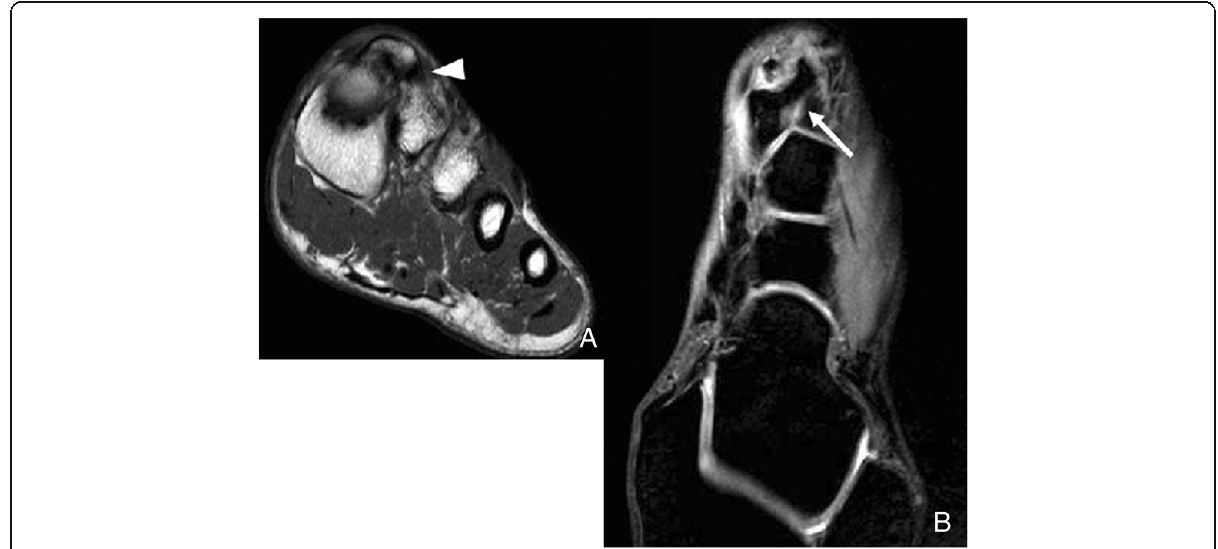
Fig. 18 Os intermetatarseum. A 36-year-old man, investigated for pain in the Achilles. Radiographs demonstrate a spur projection in the dorsum of the foot, overlying the base of the metatarsal (not shown). a Coronal FSE T1 demonstrates how this articulates with the base of the second metatarsal, with a synchondrosis (white arrowhead). b Axial three-dimensional gradient echo water selective/fluid (WATSf) demonstrates this exostosis arises from the base of the first metatarsal, and extends over the joint with the base of the second metatarsal (white arrow). These ossicles rarely represent a cause or pathology, unless compression irritates the superficial and deep peroneal